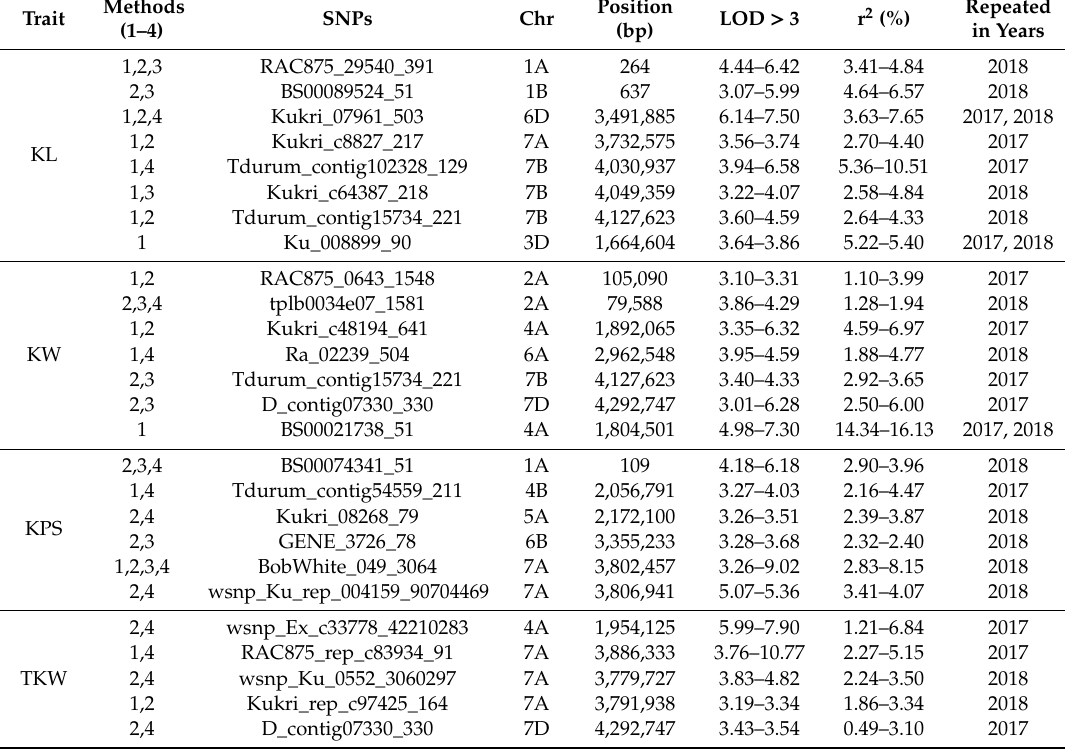
Table 1. Common SNPs identified by di ff erent multi-locus models for kernel traits (kernel length kernel width, kernels per spike, and thousand kernel